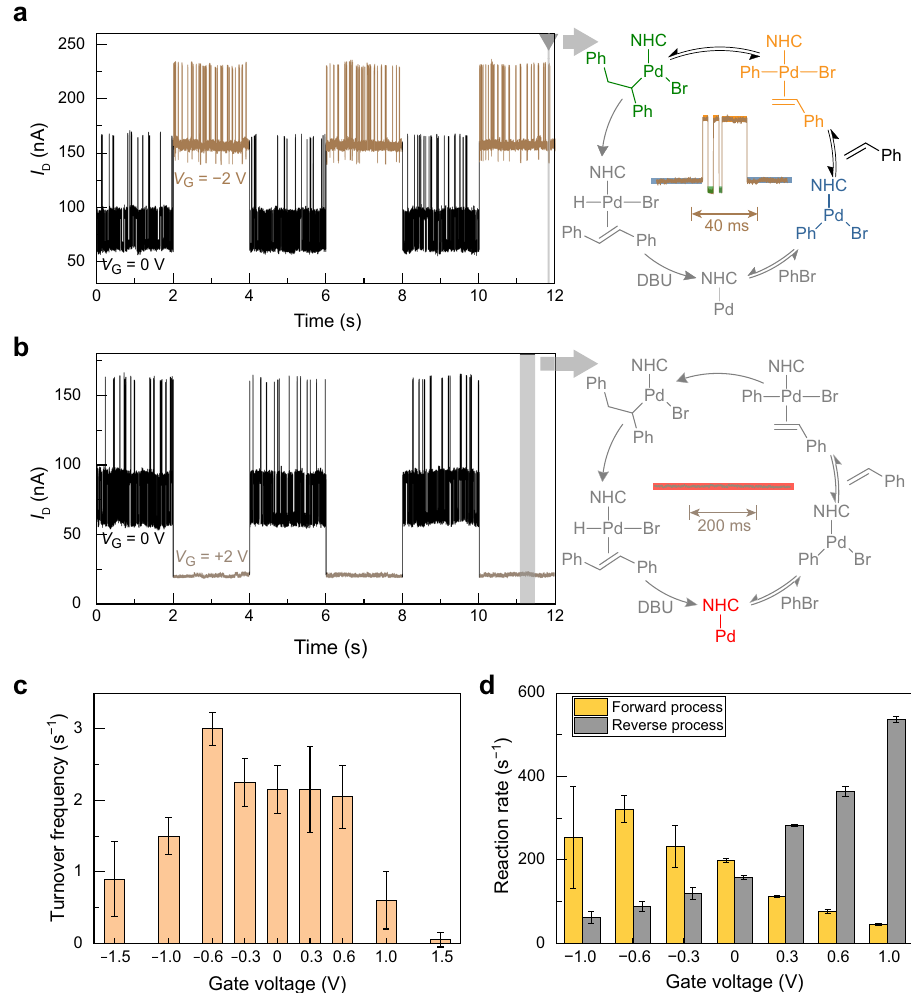
Fig. 5 | Gate tuning of the single-molecule Mizoroki – Heck reaction. Reaction conditions: 1mM PhBr, 1mM styrene and 1mM DBU in ionic liquid. a Gate-control on/off of the Mizoroki – Heck reaction via applying − 2V/0V gate voltage (left) and the in fl uenceof − 2Vgate voltageon the catalyticcycle(right).NHC N -heterocyclic carbene. b Gate-controlon/offoftheMizoroki – Heckreactionviaapplying+2V/0V gate voltage (left) and the in fl uence of +2V gate voltage on the catalytic cycle (right). c The tuning effect of the whole Mizoroki – Heck reaction under different